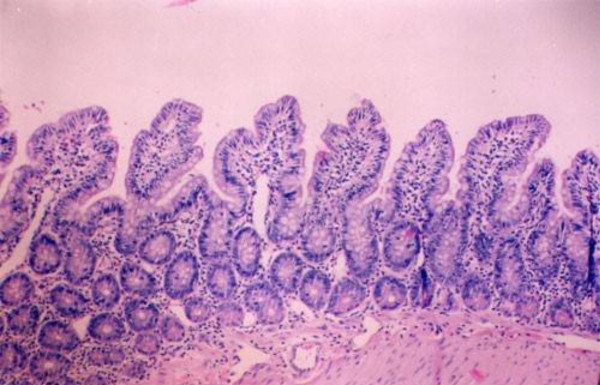
Normal intestinal mucosa in group I rats (Grade 0) (HE, ×100).